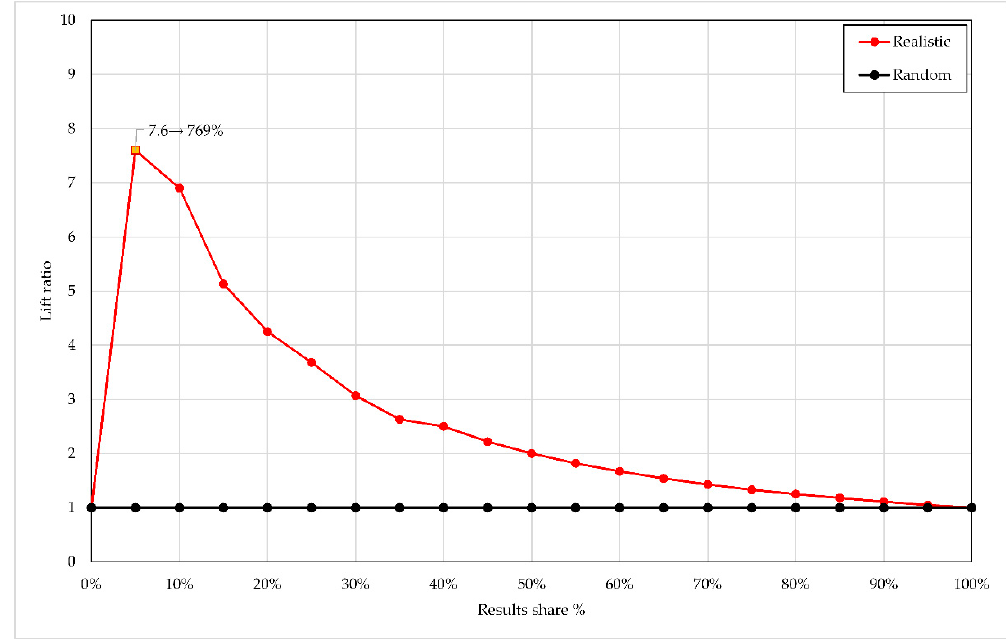
Figure 6. Lift score diagram for the lift chart of the real classifier (red series) in Figure 5. The maximum lift, as an improvement of 7.69 or 769% over random guess (black series), corresponds to the results share of 0.05 (5%).